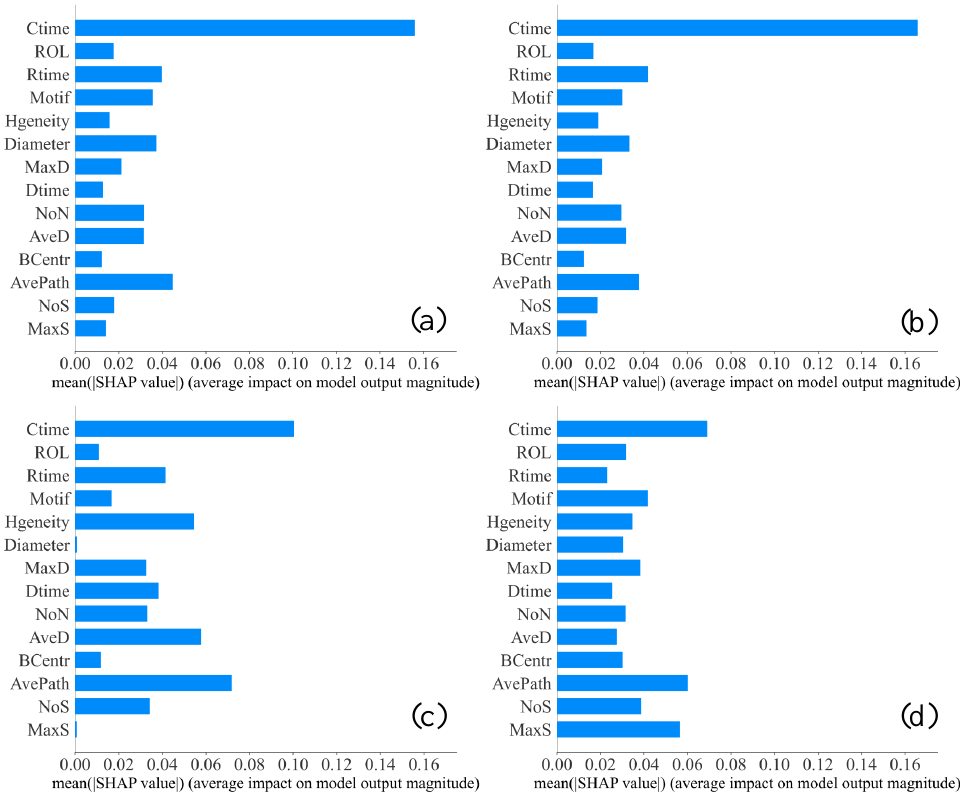
Figure 5. Mean ( | SHAP value | ) on the subsampled and original Gossipcop datasets at different cut-off times . ( a , b ) On the subsampled Gossipcop dataset, the cut-off time is 2.4 h and 12 h, respectively. ( c , d ) On the original Gossipcop dataset, the cut-off time is 2.4 h and 12 h,